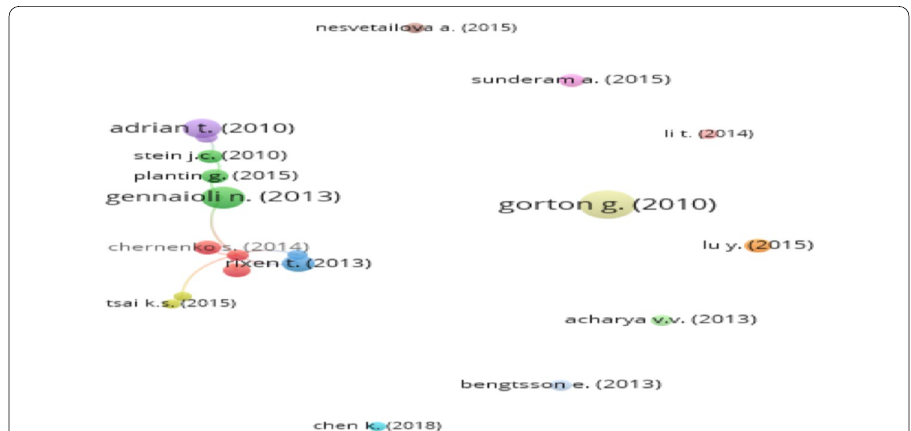
Fig. 5 Network map of the highest cited documents on SB. Source : Authors’ own estimation